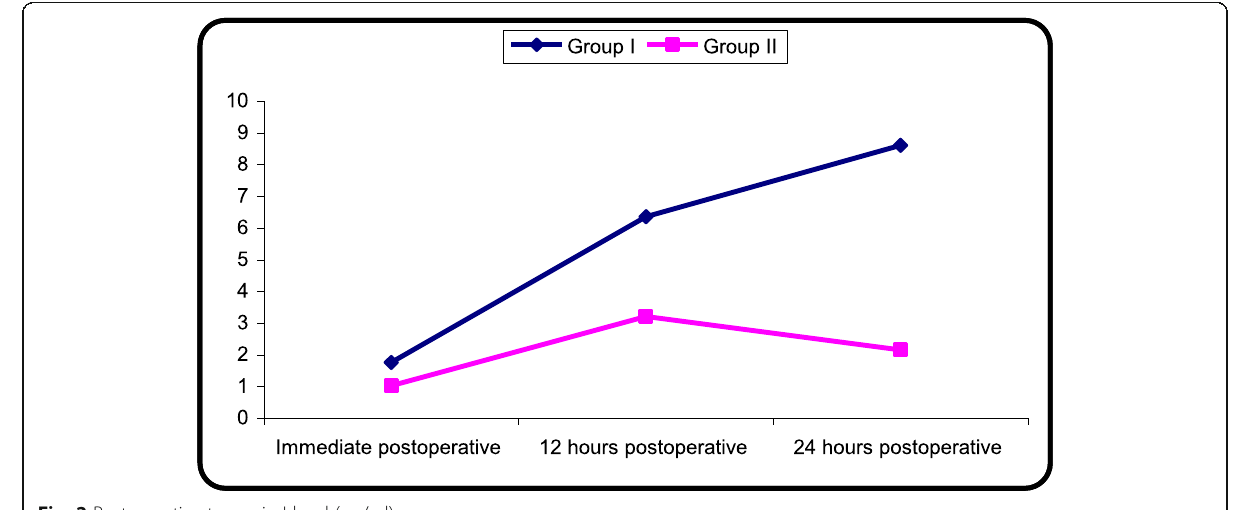
Fig. 2 Postoperative troponin I level